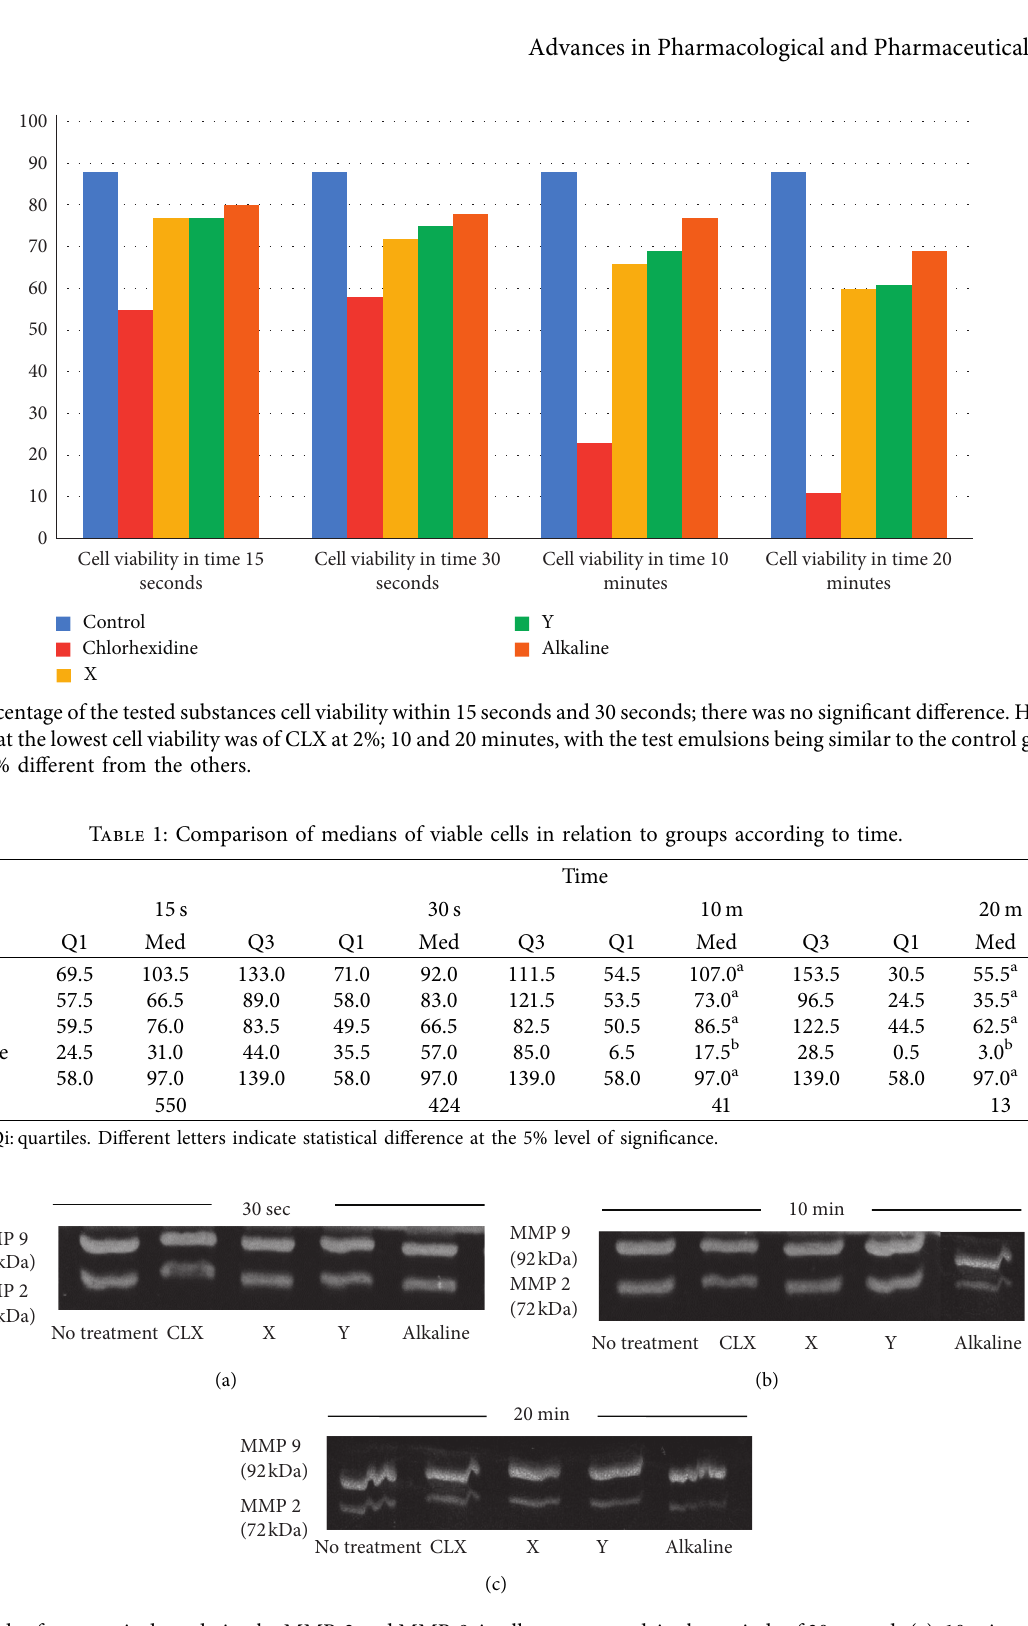
Figure 2: Bands of enzymatic degradation by MMP-2 and MMP-9, in all groups tested, in the periods of 30 seconds (a), 10 minutes (b), and 20 minutes (c).